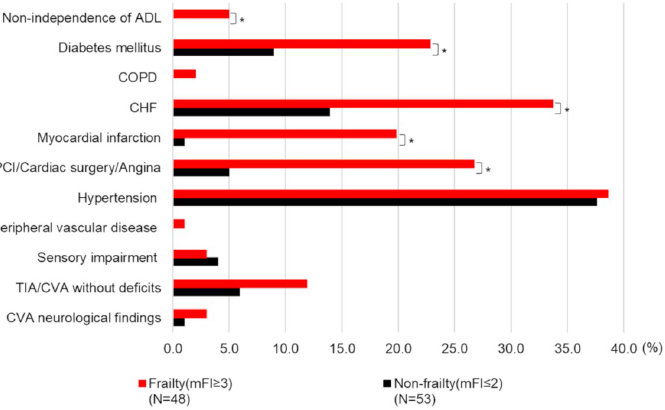
Fig 2. Comparison of the mFI subitem results between groups. ADL = activities of daily living; CHF = congestive heart failure; COPD = chronic obstructive pulmonary disease; CVA = cerebral vascular accident; PCI = percutaneous coronary intervention; TIA = transient ischemic attack. Other abbreviations are same as Table 1.